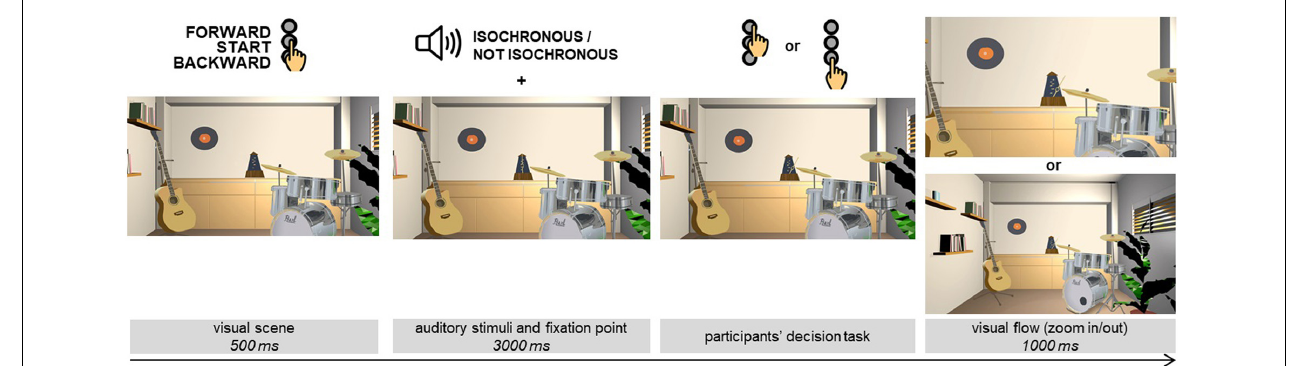
FIGURE 2 | Schematic representation of the experimental procedure.